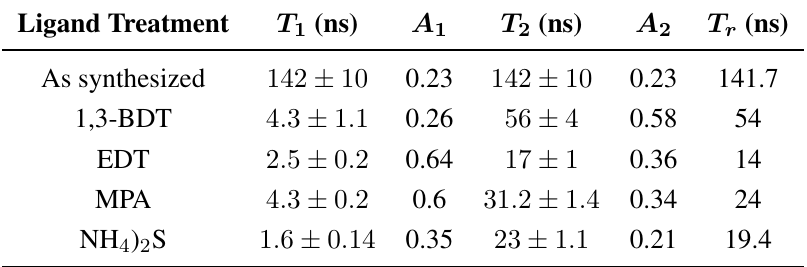
Table 1. Transient photoluminescence fitting results and the calculated intensity reduced exciton lifetime T r